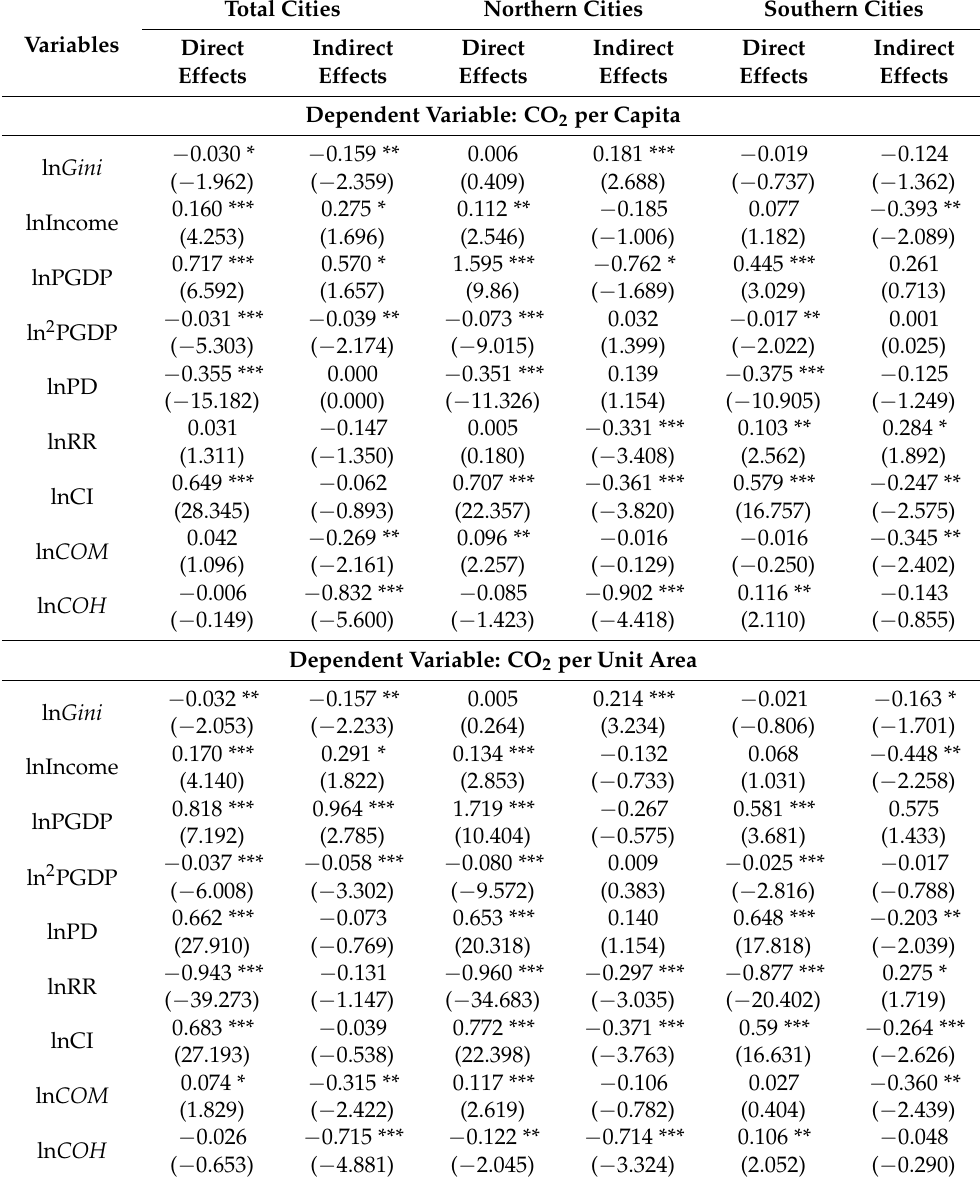
Table 3. Differentiation results of factors influencing CO 2